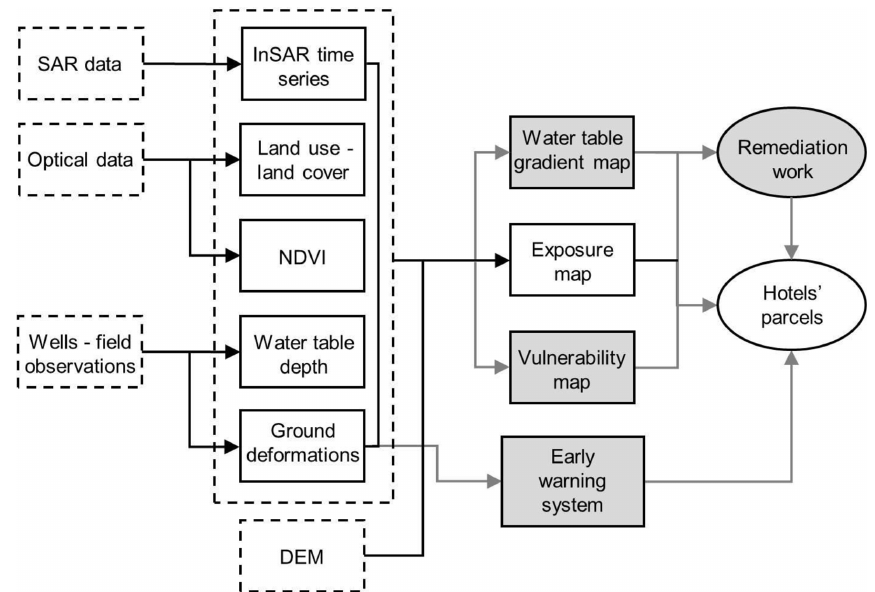
Figure 3. Flow chart of the methodology applied in this research (black rectangles). Rectangles coloured in grey indicate the future targets of the